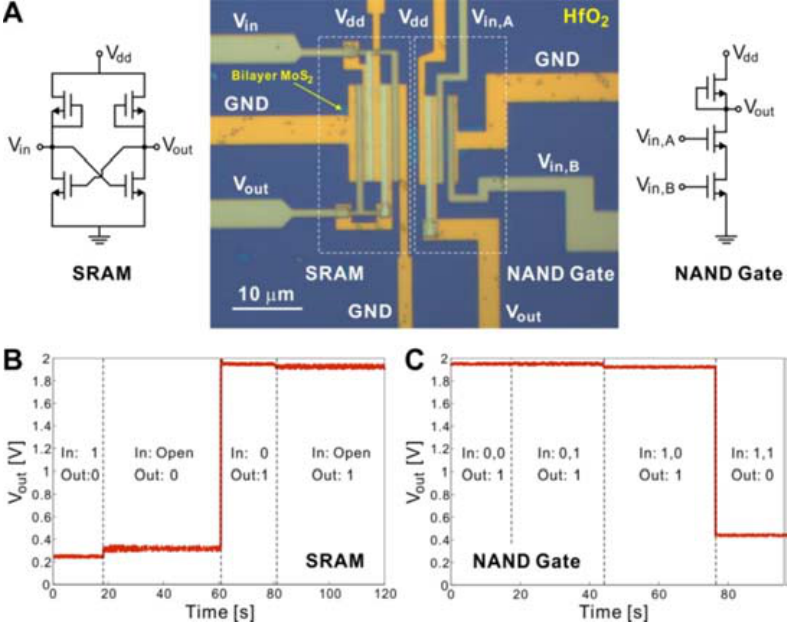
Figure 20. Demonstration of an integrated NAND logic gate and a static random-access memory (SRAM) cell on bilayer MoS 2 . ( A ) Optical micrograph of the NAND gate and the SRAM fabricated on the same bilayer MoS 2 thin film. The corresponding schematics of the electronic circuits for the NAND gate and SRAM are also shown. ( B ) Output voltage of the flip-flop memory cell (SRAM). A Logic State 1 (or 0) at the input voltage can set the output voltage to Logic State 0 (or 1). In addition, the output logic state stays at 0 or 1 after the switch to the input has been opened. ( C ) Output voltage of the NAND gate for four different input states: (0,0), (0,1), (1,0), and (1,1). A low voltage below 0.5 V represents Logic State 0 and a voltage close to 2 V represents Logic State 1. Reproduced with permission from [249], American Chemical Society, 2012.